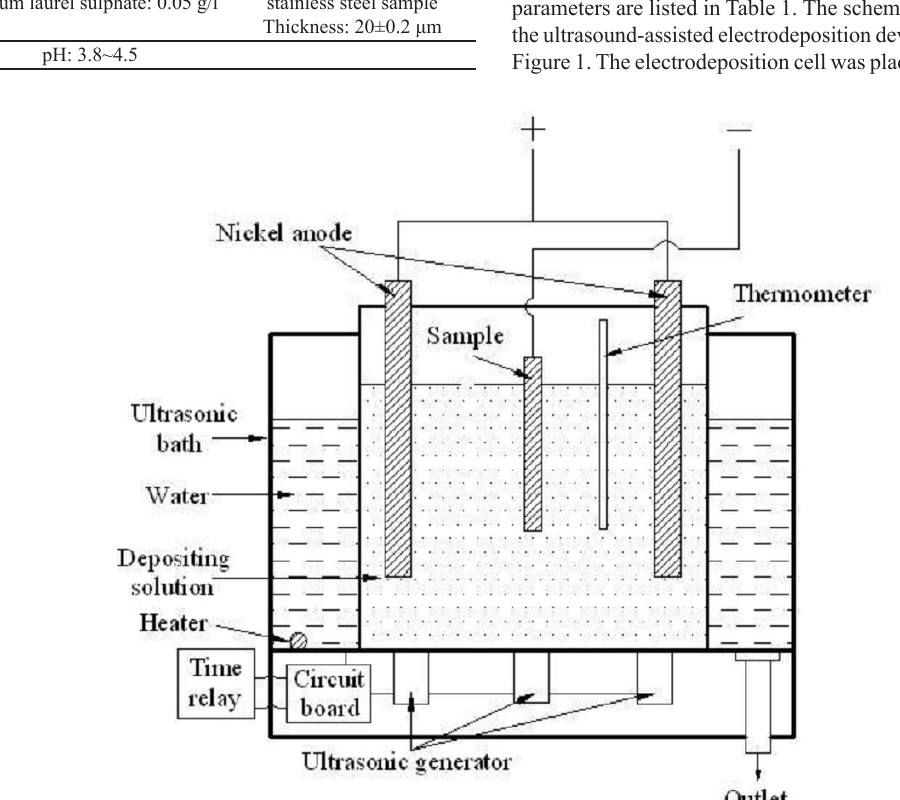
Figure 1. Schematic diagram of the ultrasound-assisted electrodeposition